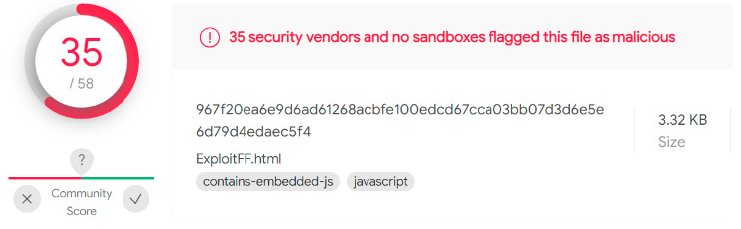
Figure 13. Malware detection in a JavaScript file.